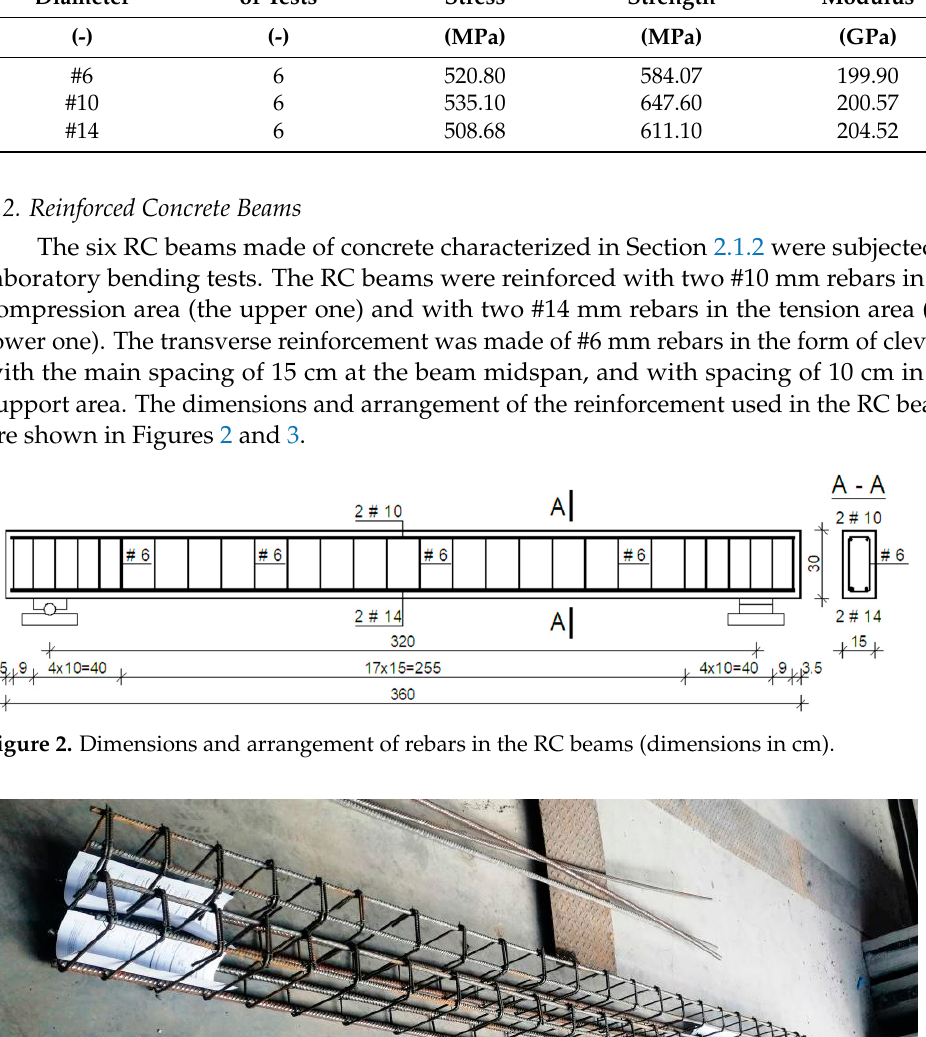
Figure 3. The arrangement of rebars for the RC beams before concreting.